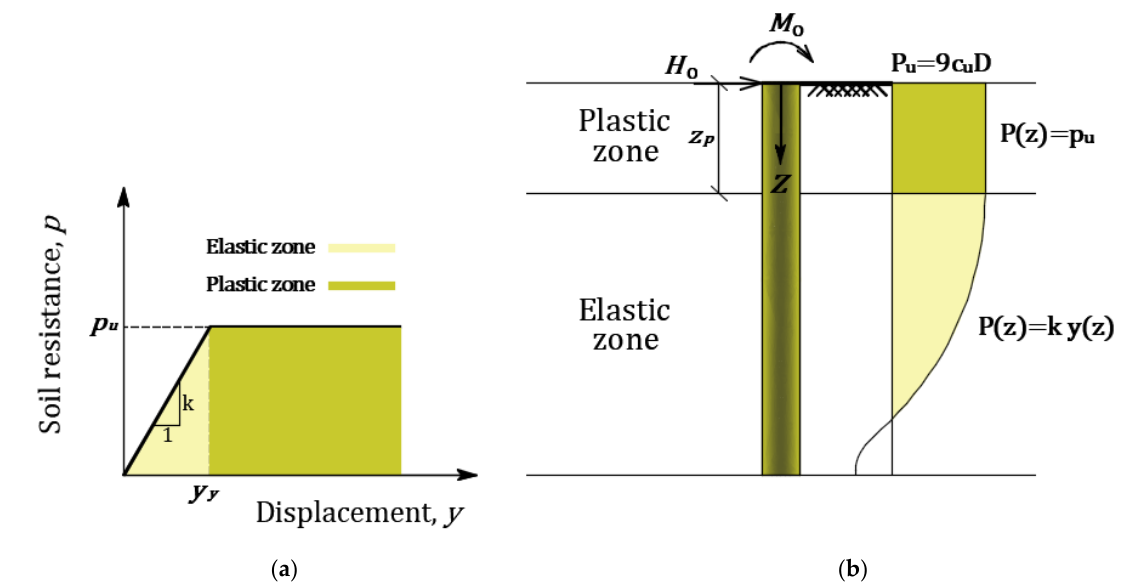
Figure 2. ( a ) Elasto-plastic behavior of the soil, ( b ) lateral soil reaction distribution [14].